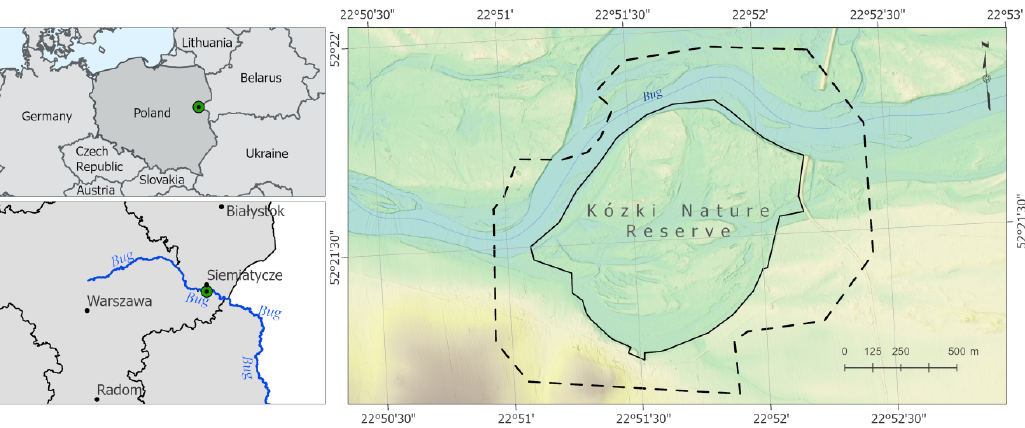
Figure 2. The location of the “Kózki” Nature Reserve area in East Poland ( upper left ) near Siemiatycze ( bottom left ) as a central part of the research area delineated by the dashed line ( right ).